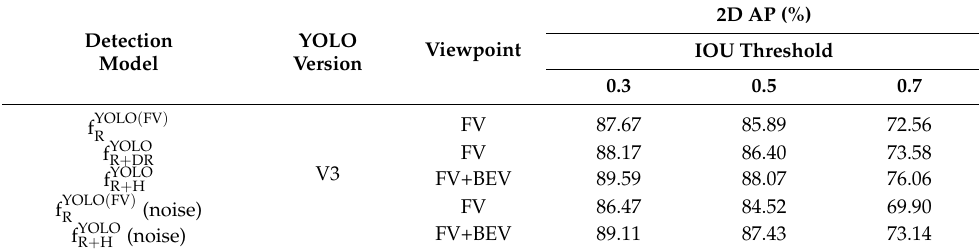
Table 3. Performance comparisons for entire KITTI